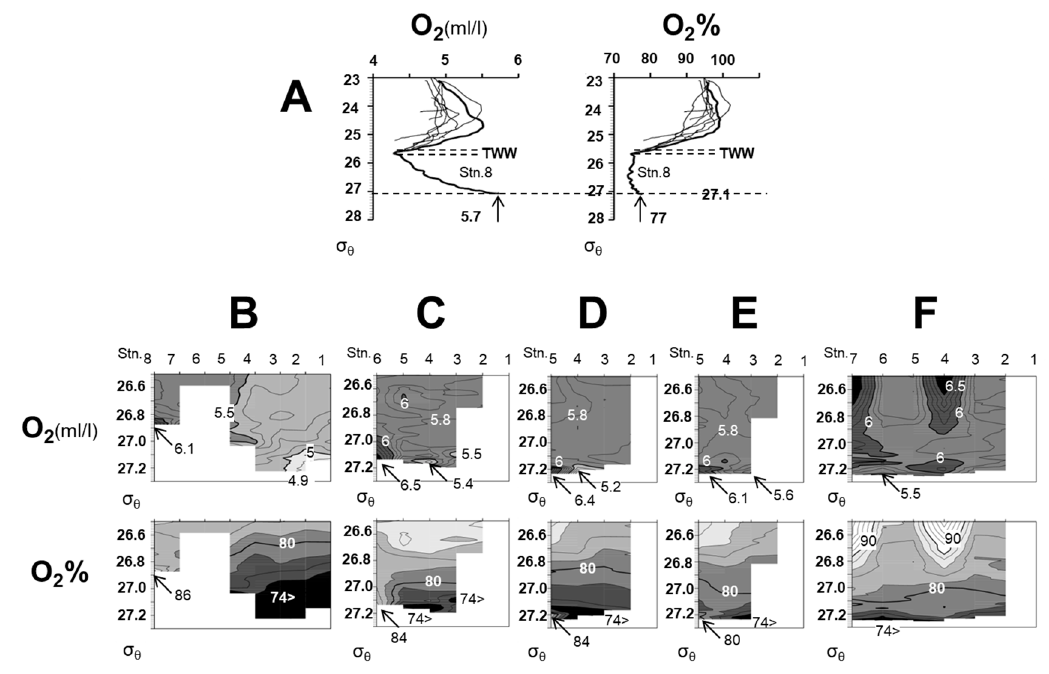
Figure 9. The vertical profile of O 2 and O 2 % along line ( A ), and the vertical cross-sections of O 2 and O 2 % along lines ( B ) to ( F ) where the depth is represented by σ θ .